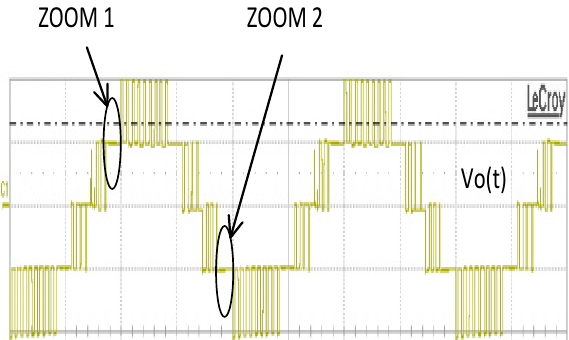
Figure 23. Output voltage during OPT-PWM control.